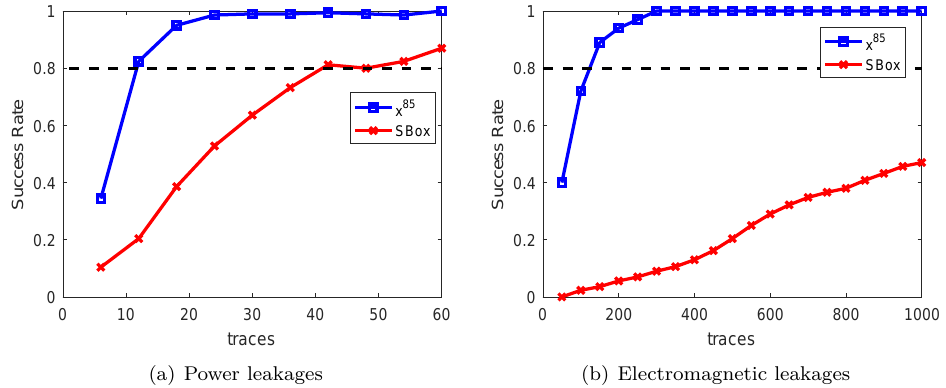
Figure 13: The success rate for ETA on practical